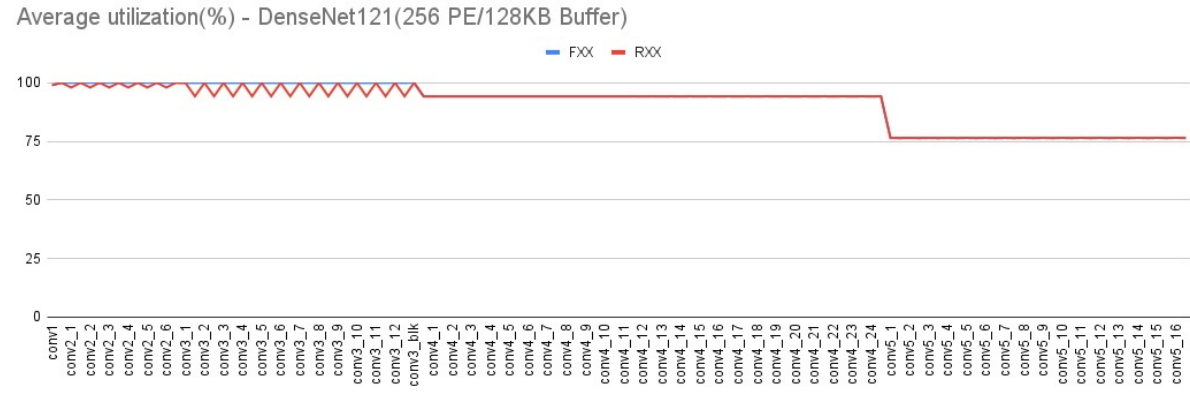
Figure 20. Average PE utilization—DenseNet121 (256 PE/128 KB Buffer). Table 3. Overhead of reconfigurable